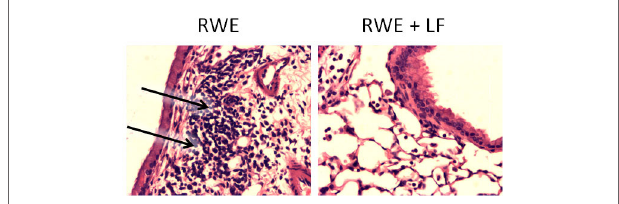
FigURe 6 | Effect of lactoferrin (LTF) on ragweed pollen (RWE)-induced accumulation of inflammatory cells into subepithelium. Mice challenged with RWE demonstrated high-inflammatory cell infiltrates within peribronchial region (arrows) postchallenge (left), but not in the LTF-treated mice (right). Sections were stained with hematoxylin and eosin and visualized at 100 × magnification. Photomicrographs were previously described in detail, and represent studies published in Kruzel et al. (38).